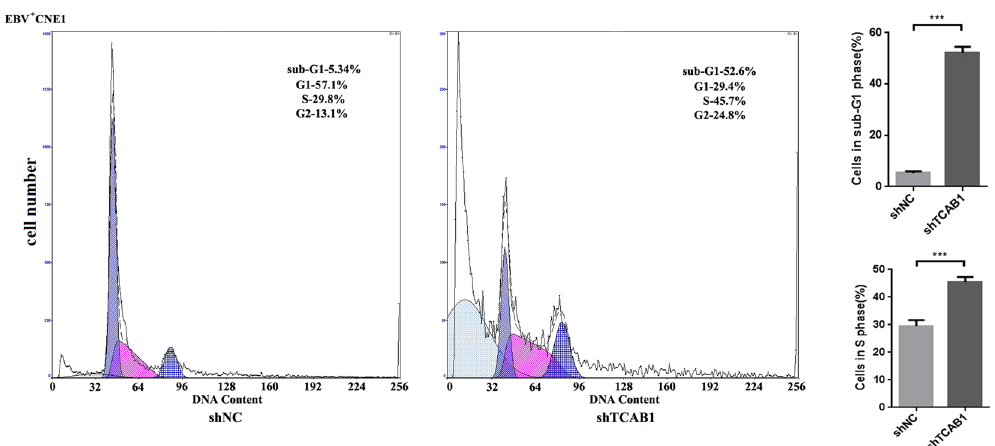
Figure 5. Depletion of TCAB1 promotes apoptosis and cell cycle arrest in vitro . Depletion of TCAB1 using exogenous shTCAB1 lentivirus inhibited cell cycle progression of EBV-positive CNE1 cells, and significantly more shTCAB1-treated cells were in sub-G1 phase than in S phase. The statistical analysis was performed using Student’s t test ( *** P <